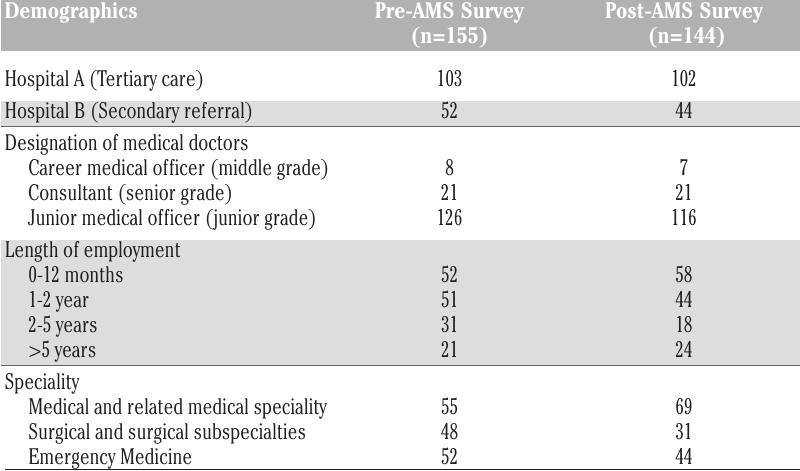
Table 1. Demographic characteristics of the survey